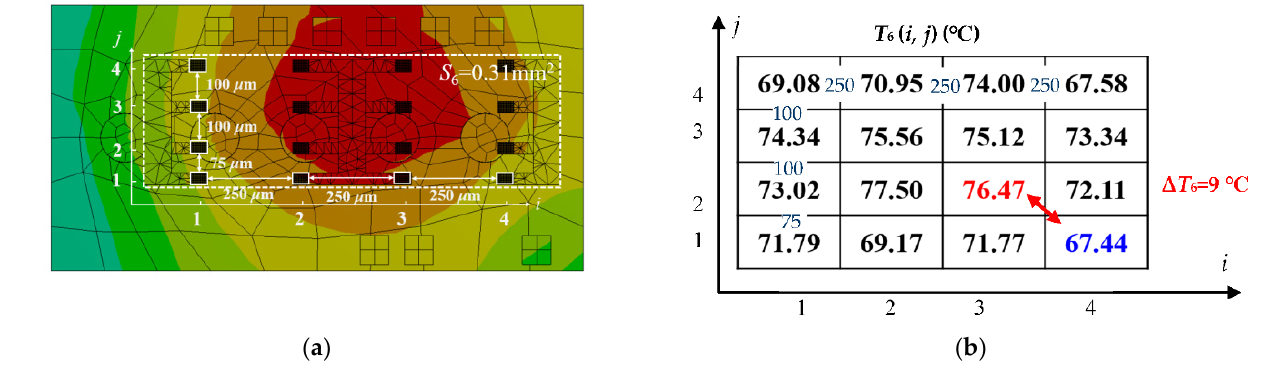
Figure 13. ( a ) 6th thermal model; ( b ) Temperature distribution of 6th thermal model.